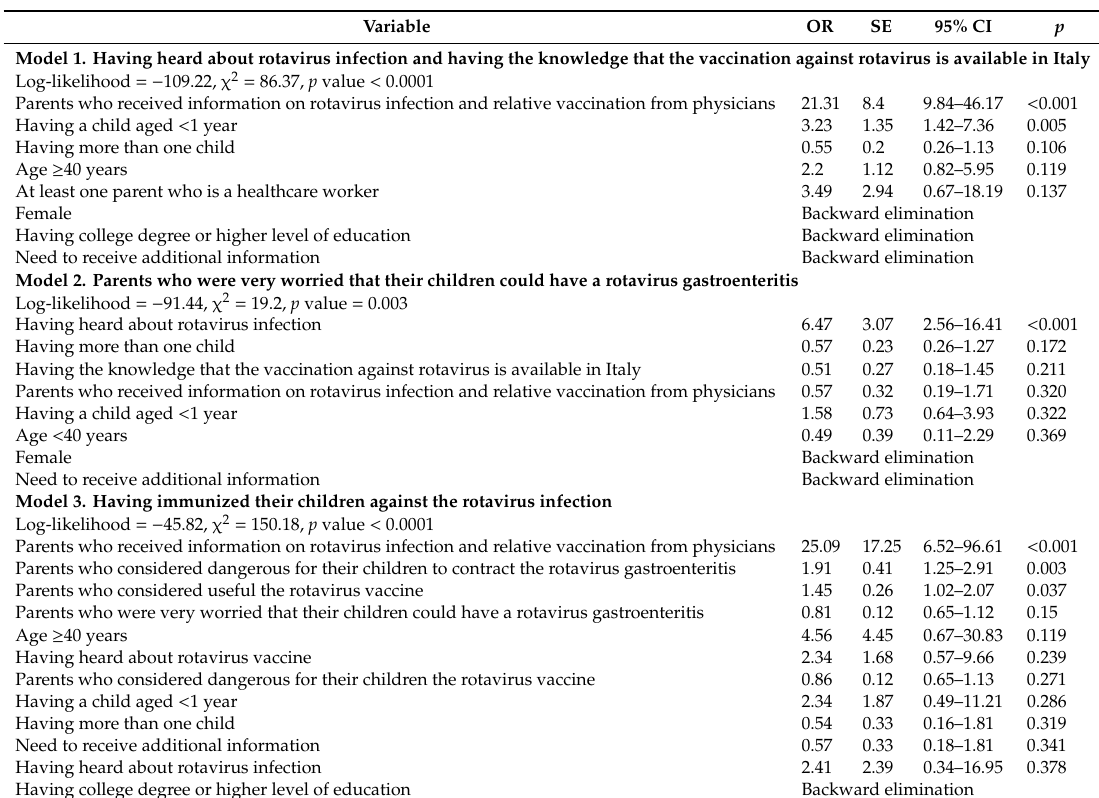
Table 3. Multivariate analysis